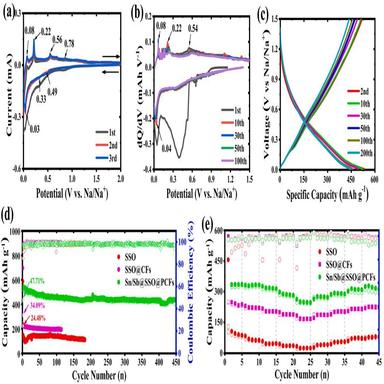
(a) Sn/Sb@SSO@PCFs electrode CV curves with scan rates of 0.1 mV s−1; (b) dQ/dV of the Sn/Sb@SSO@PCFs samples in the 1st, 10th, 30th, 50th, and 100th cycles; (c) Charge and discharge comparison of the Sn/Sb@SSO@PCFs samples in the 2nd, 10th, 30th, 50th, 100th, and 200 cycles; (d) Comparison of the cycling stability of different samples at current density of 50 mAh g−1, and (e) Rate compare of the different samples at different varied densities at 30, 50, 100, 200, and 500 mA g−1.